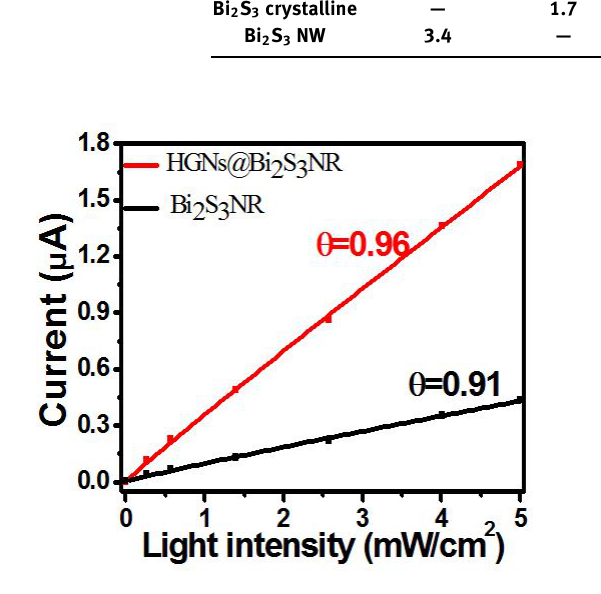
Fig. 6. The fitting of the relationship between the photocurrent and light intensity for devices based on both pure Bi 2 S 3 NR